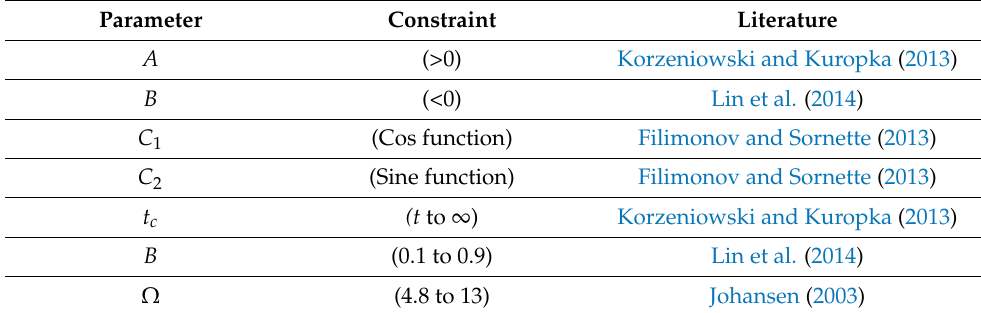
Table 1. Stylized facts of the LPPL.